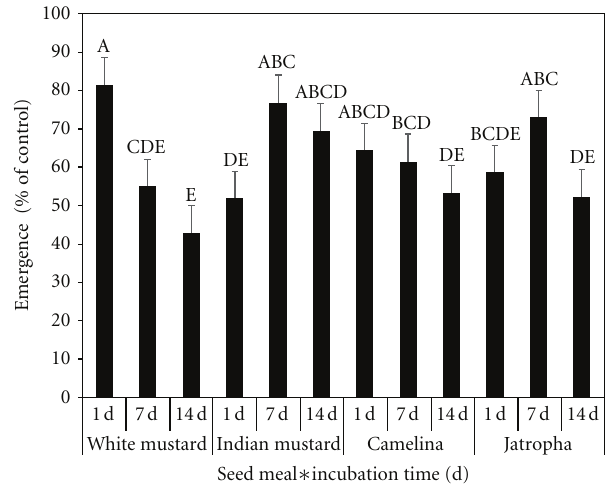
Figure 9: Interactive e ff ect of “seed meal source and incubation time” on sorghum emergence. Emergence means followed by the same letter are not di ff erent at P < 0 . 05 by Fisher’s protected LSD. Interaction e ff ects on sorghum survival were not significant ( P = 0 . 1825); therefore, the data is not shown. Data are means (four replications) ±